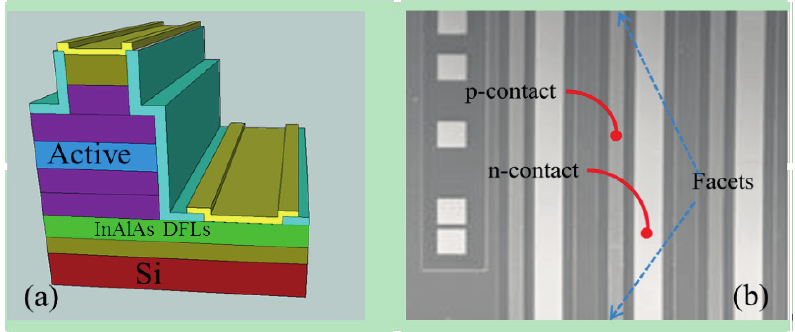
Figure 3. ( a ) Schematic of the Si-based laser. ( b ) SEM image of the final laser devices (top